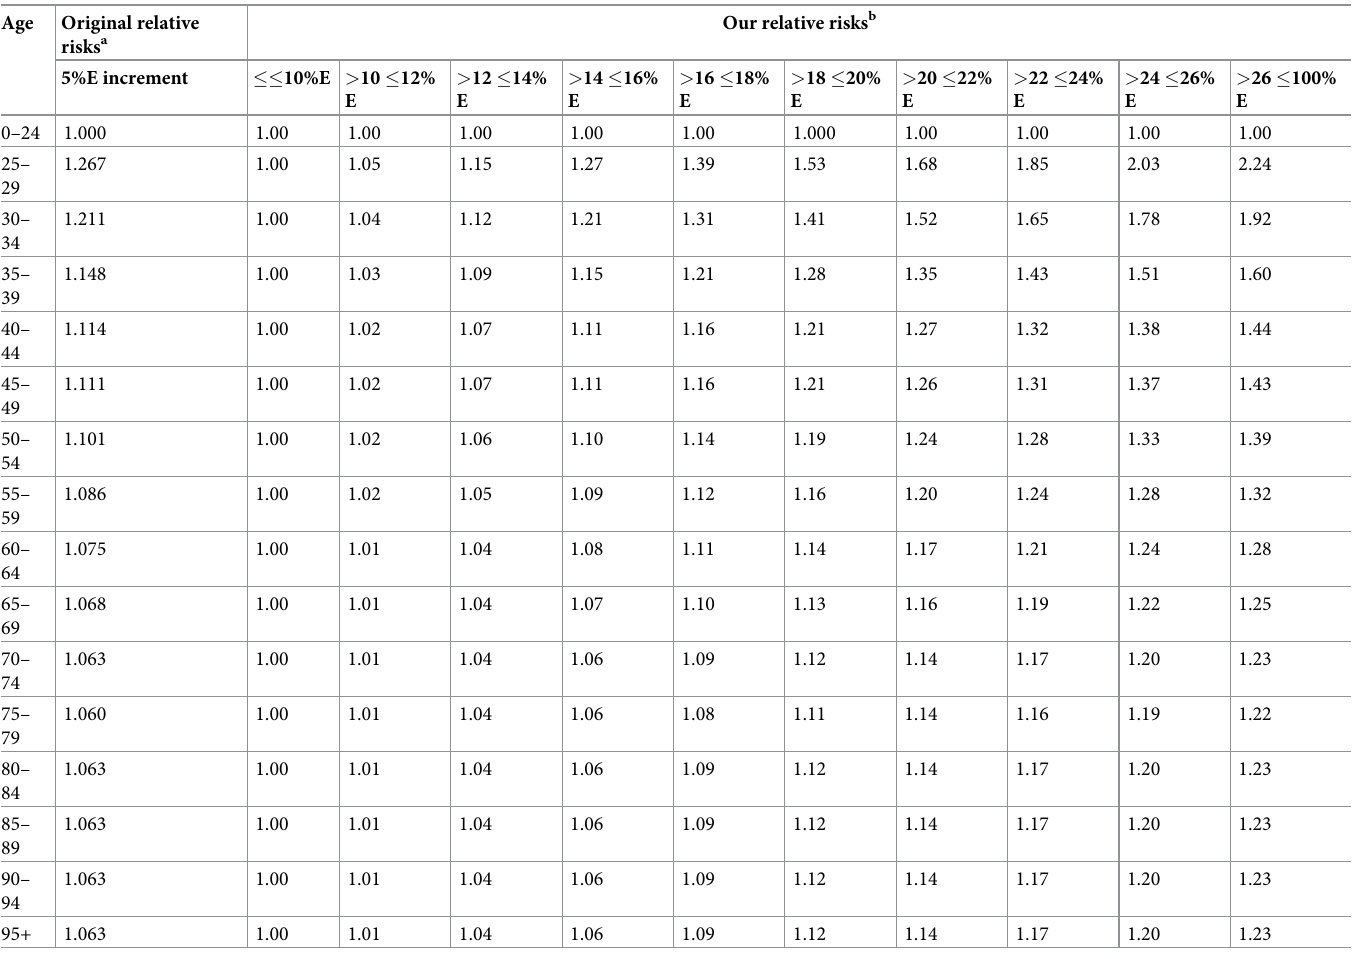
Table 1. Relative risks of ischemic heart disease associated with saturated fat